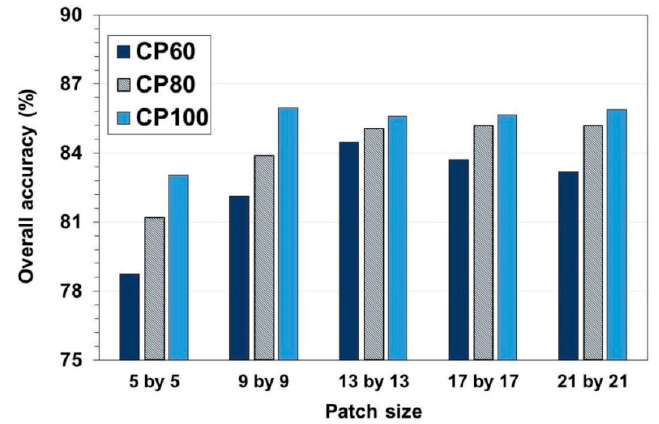
Figure 6. Variations in overall accuracy with respect to five different patch sizes for different class purity values in Anbandegi.